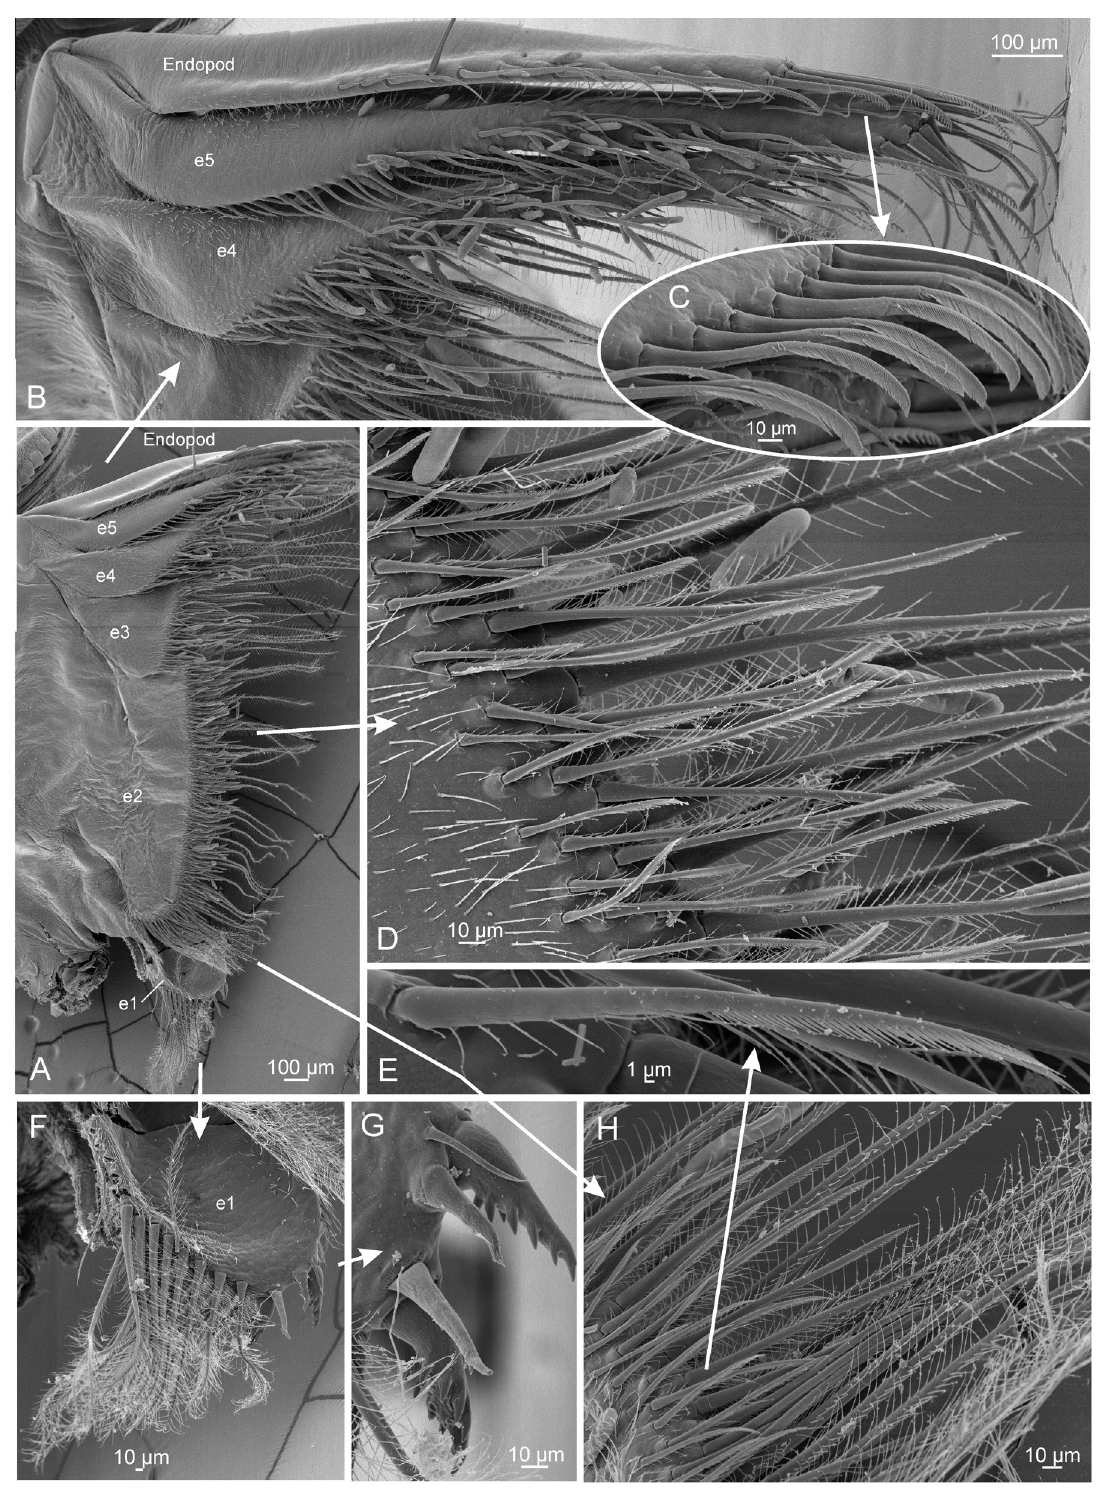
Fig. 8 . Lynceus insularis sp. nov., ♀, scanning electron microscopy (paratype, ZMUC-CRU-4787). Thoracopod 1 of left side from anterior. A . View of entire limb. B . Endites 4–5 and endopod. C . Close-up of scraping setae of endopod. D . Close-up of marginal setation of endite 2. E . Close-up of intermediate- sized seta of endite 2. F . Endite 1. G . Close-up of spiniform setae of endite 1. H . Close-up of proximal setae of endite